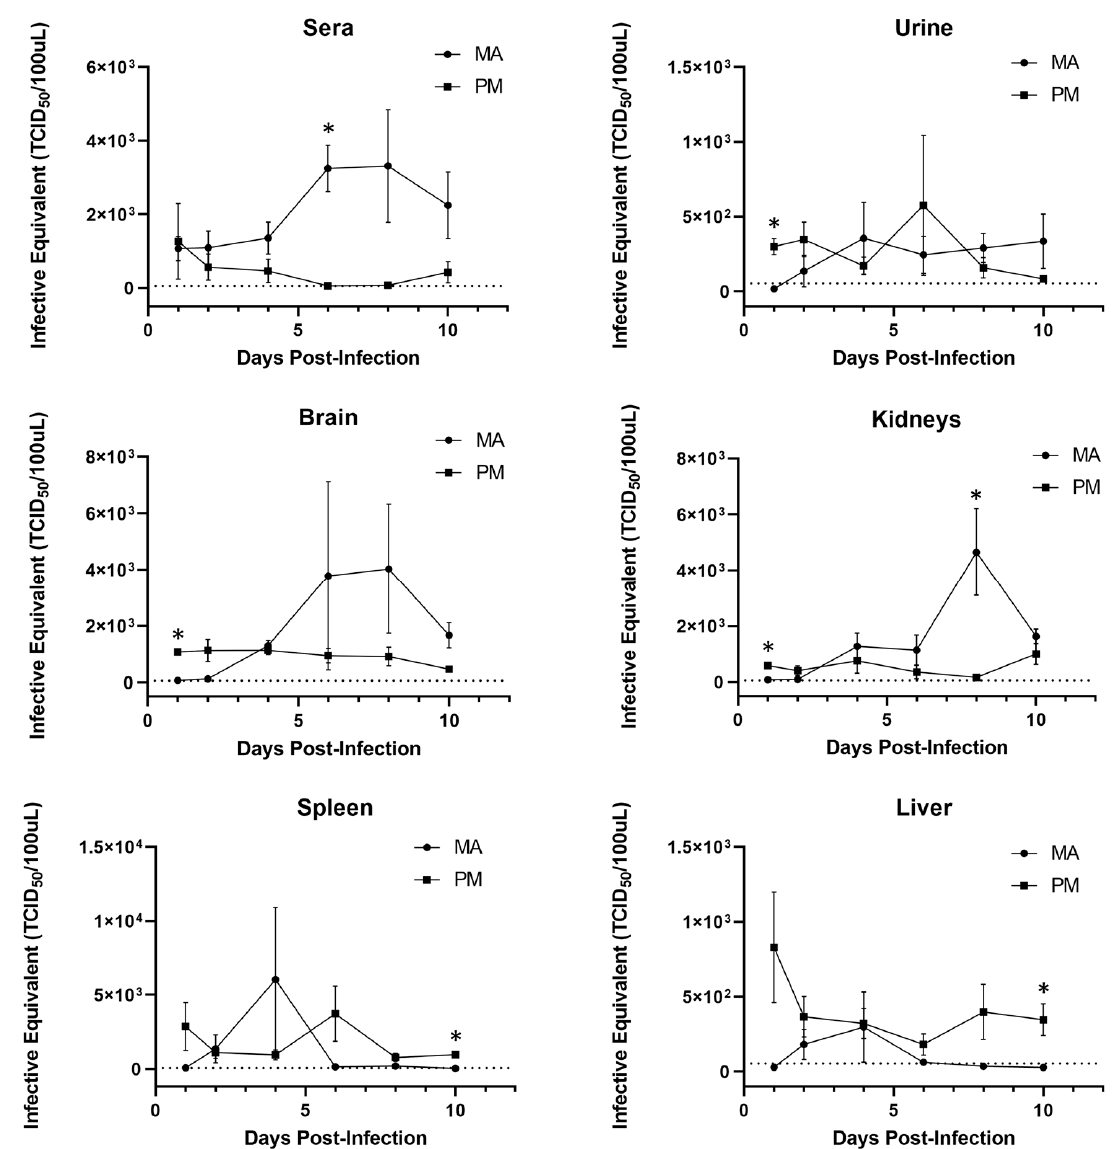
Figure 2. Viral RNA detected in select tissues and fluids of Peromyscus maniculatus (PM, squares) and Mesocricetus auratus (MA, circles). Viral RNA quantified via RT-qPCR was translated into TCID 50 equivalent titers. Datapoints represent the mean (+/ − SEM) viral load recovered from infected replicates at each timepoint ( n = 3). Asterisks (*) represent a significant difference in RNA loads between each species at a particular timepoint, as determined by Mann – Whitney tests. Dotted lines represent the limit of detection at an infective equivalent of approximately 10 1.7 TCID50.